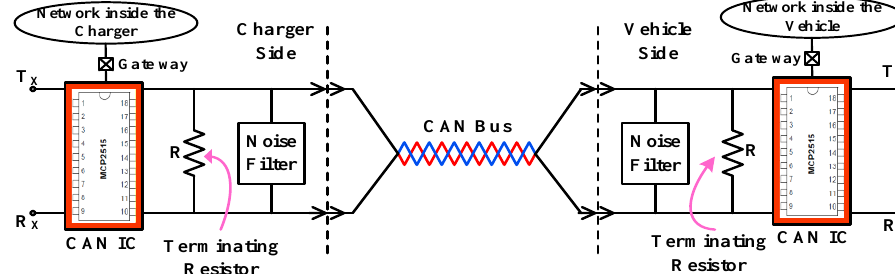
Figure 6. CAN bus communication circuit.